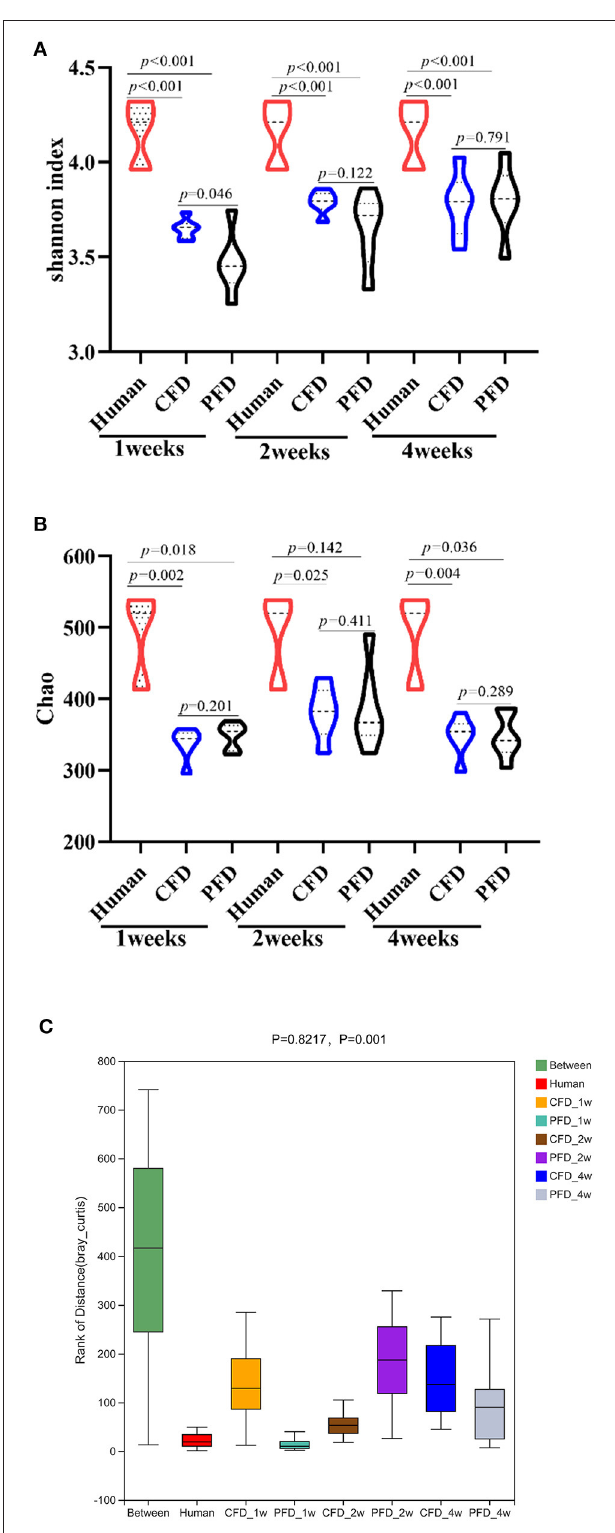
FIGURE 3 | Bacterial alpha-diversity indices including (A) Shannon diversity index (B) Chao. (C) Distance calculated on OTU level of each sample group by Anosim analysis. There was a big difference in all groups. Statistical significance was denoted by p